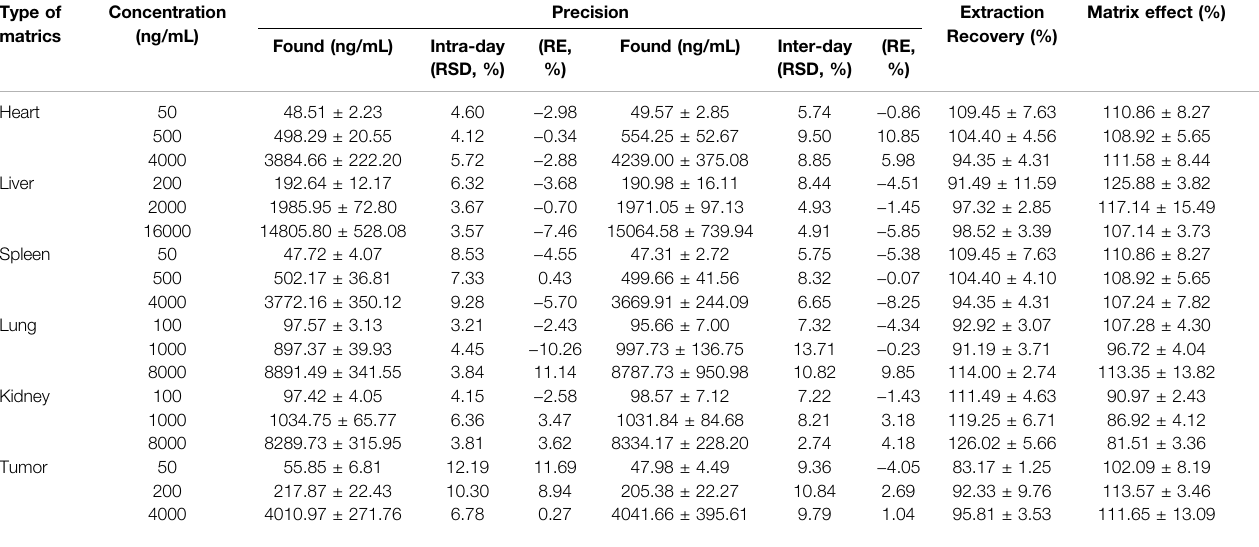
TABLE 1 | Precision, accuracy and recovery of PTX in tissue using HPLC-MS/MS (Mean ± SD, n=5). Type of Concentration matrics (ng/mL)